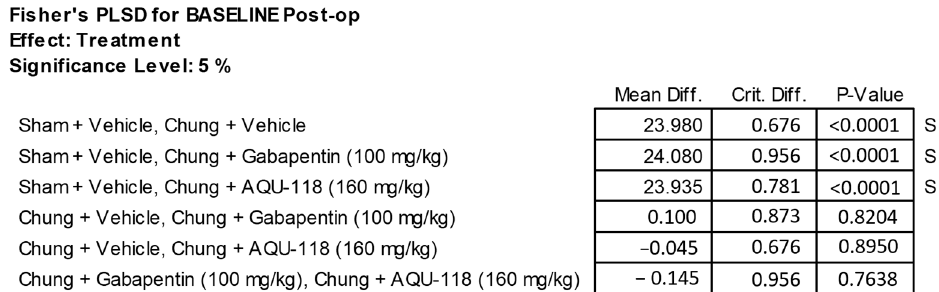
Figure A2. Fisher’s protected least significant difference (PLSD) test of post-operative VF baseline PWT of the ipsilateral hind paws.